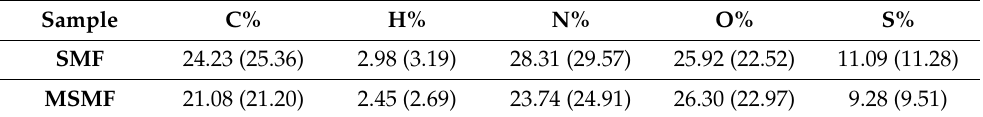
Table 1. Elemental analyses of SMF and MSMF. Values in parentheses indicate expected contents.